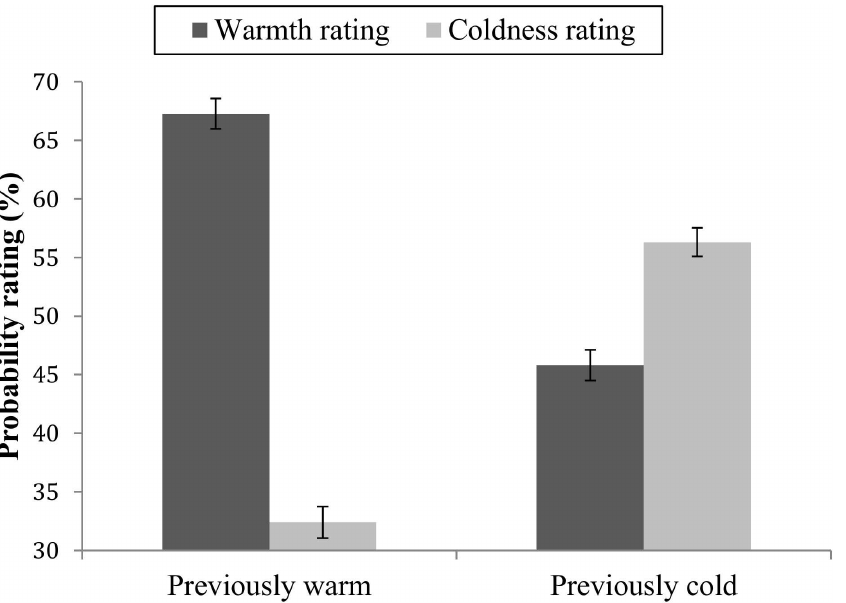
Fig 2. Mean probability ratings of future warm and future cold behaviors. Ratingsof targets with previously mainly warm or mainly cold behavior.Error bars represent standarderrors.